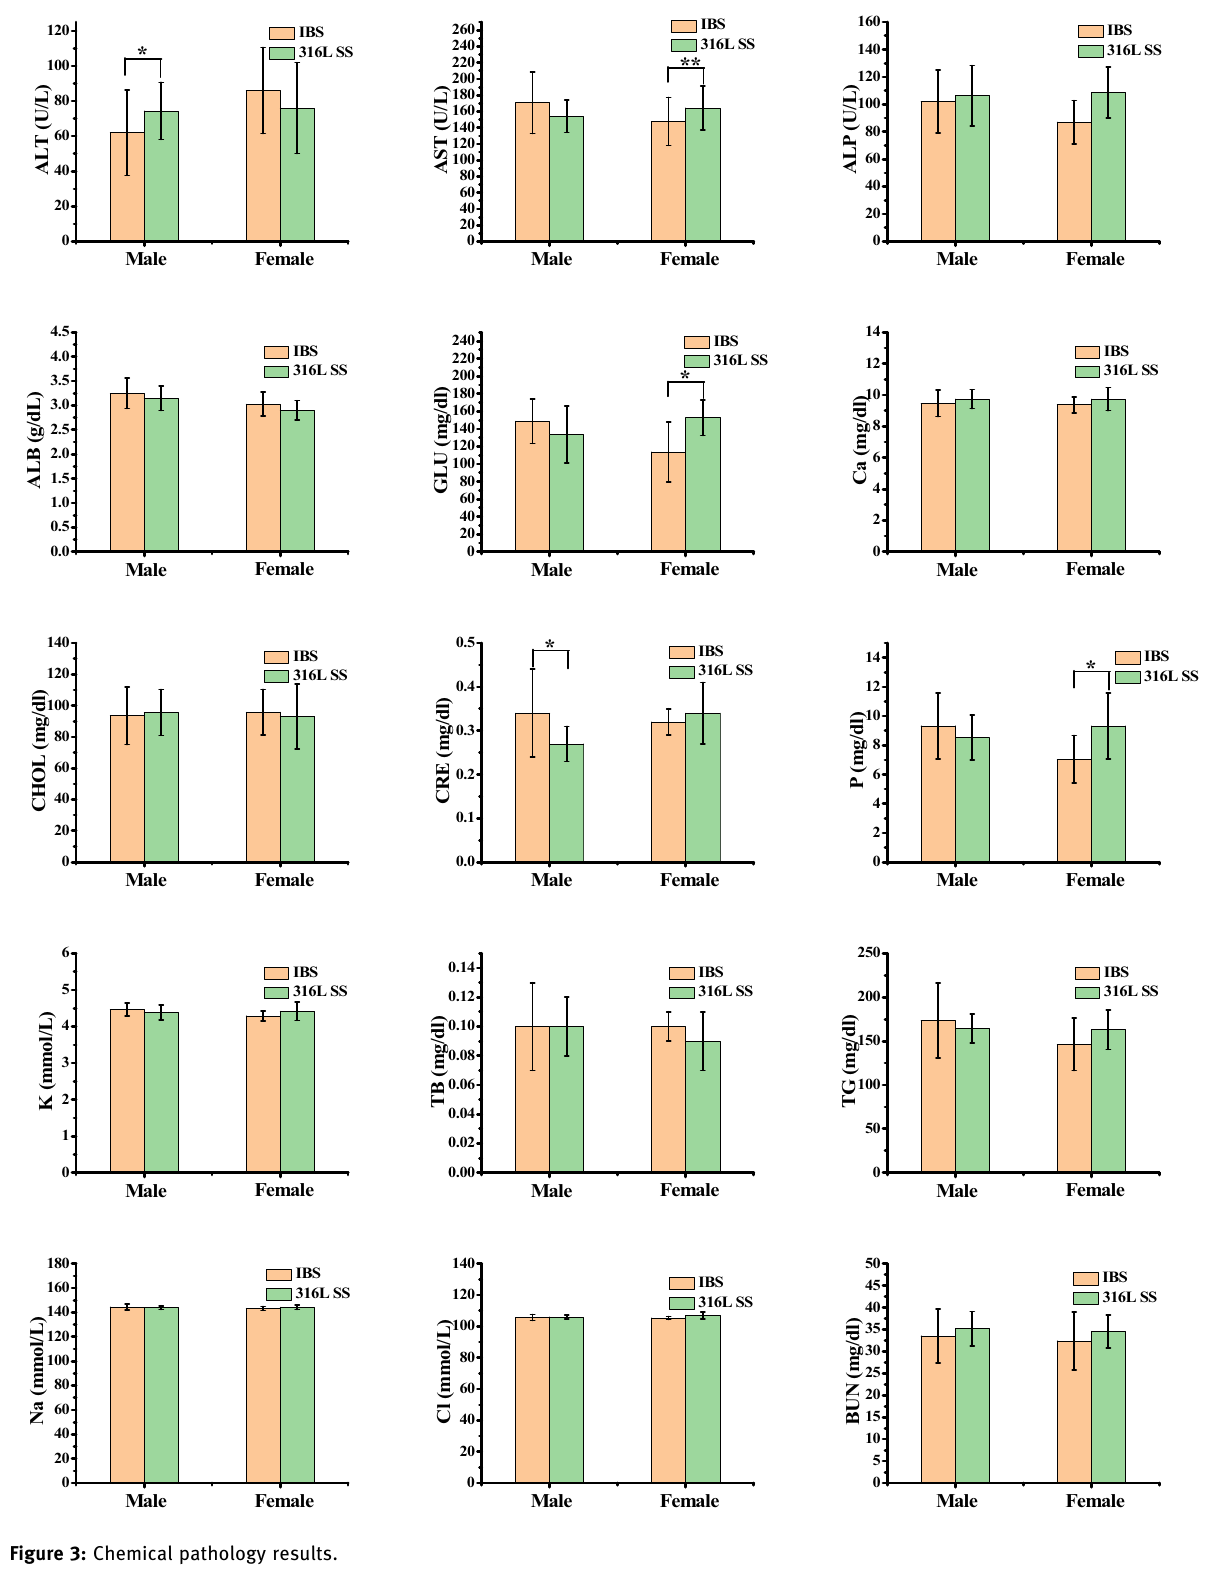
Figure 3: Chemical pathology